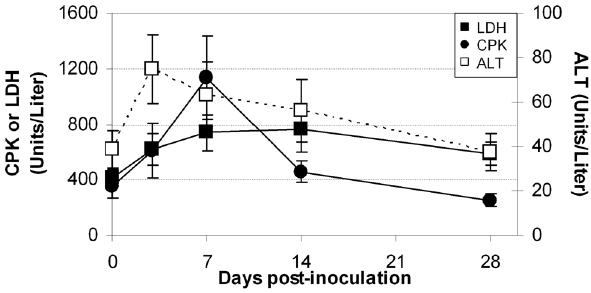
Figure 4. Biomarkers measured in animals inoculated with low N dose (10 6 pfu) CVB-H3 or CVB-MCH. Serum, unfractionated LDH ), and ALT ( % ) are represented as mean + / 2 SEM for ( & ), total CPK ( all 6 animals at each